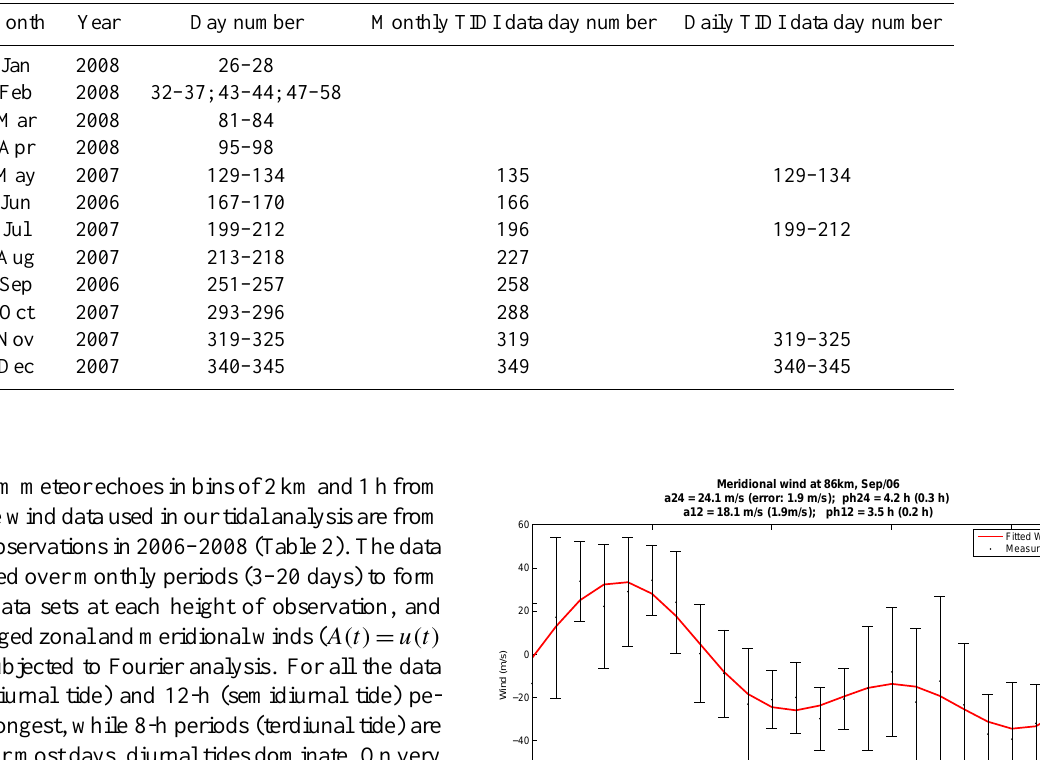
data (see Table 2 for the daily TIDI data used in